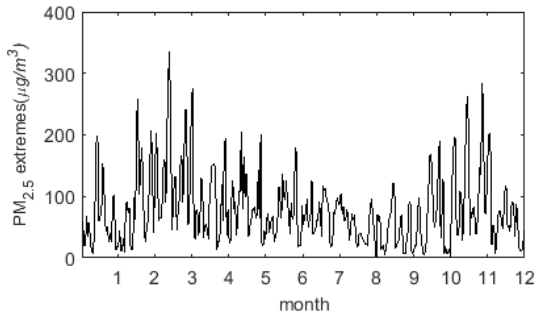
Figure 5. Daily maximum PM 2.5 level ( µ g/m 3 ) of Beijing in